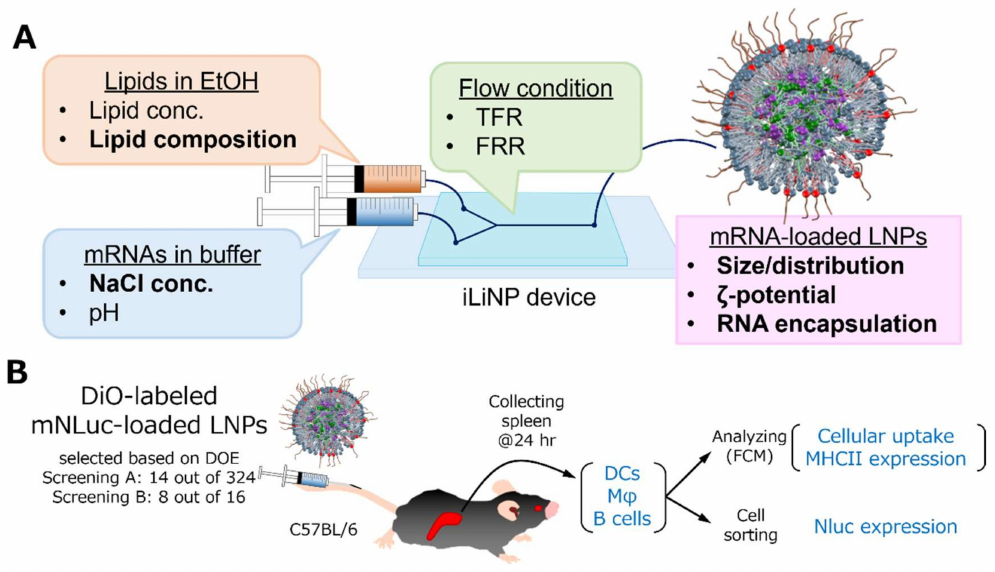
Figure 1. Schematic illustration of the experimental method for DOE. ( A ) Parameters and responses in manufacturing LNPs. Both parameters and responses examined in this study were expressed in bold. ( B ) Method for screening of LNPs in vivo. Cellular uptake, NHC class II expression, and Nluc expression in splenic DCs, M ϕ , and B cells after intravenous injection of DiO-labeled mNLuc-loaded LNPs selected by DOE were measured to identify the optimal